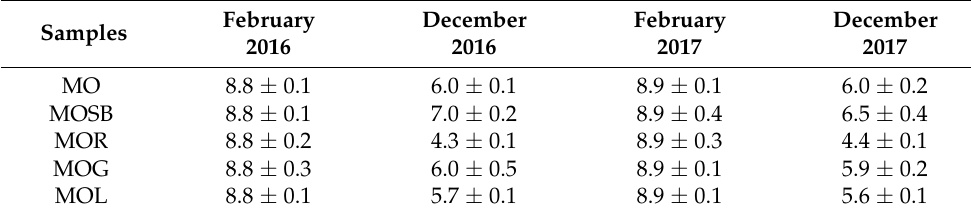
Table 12. Oxidative stability (h) of all olive oils.